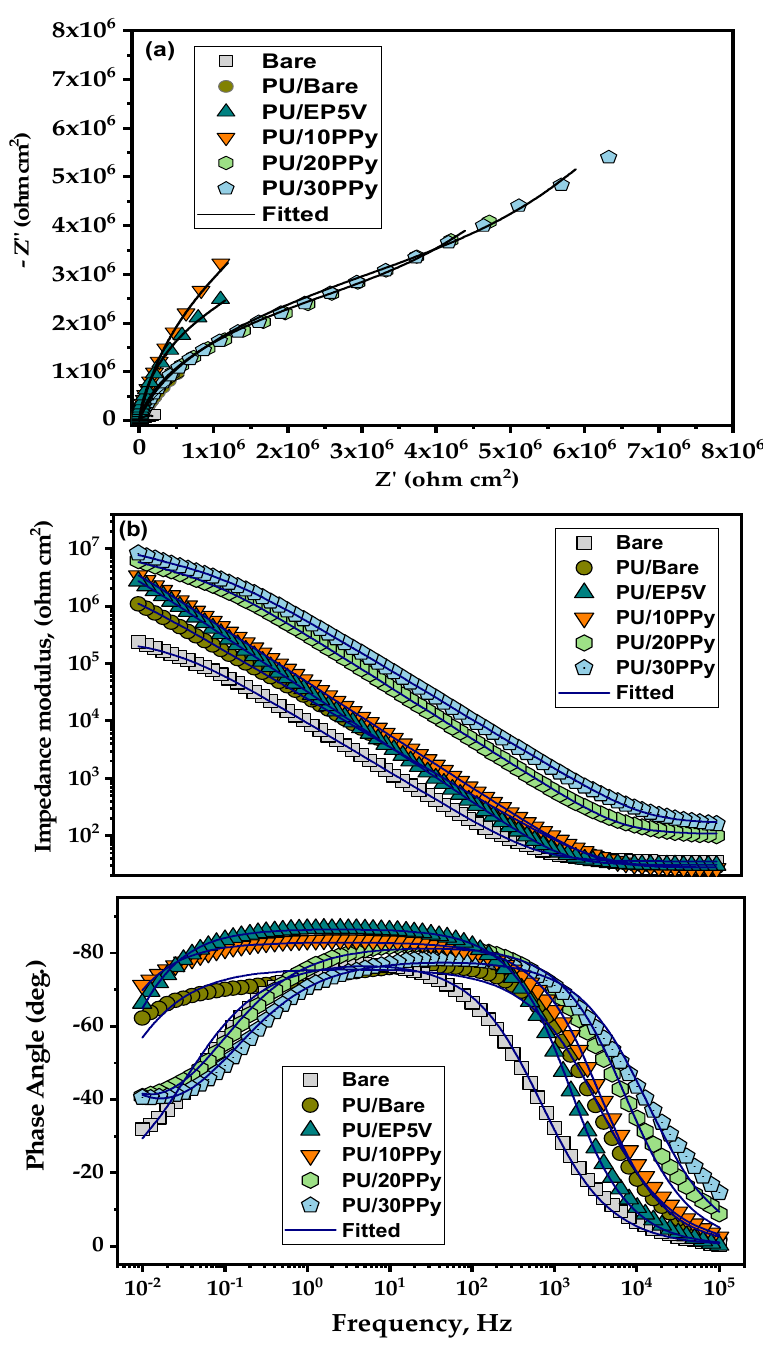
Figure 9. ( a ) Nyquist plots; ( b ) Bode plots of prepared coatings on passivated and bare specimens in a 3.5% NaCl solution.